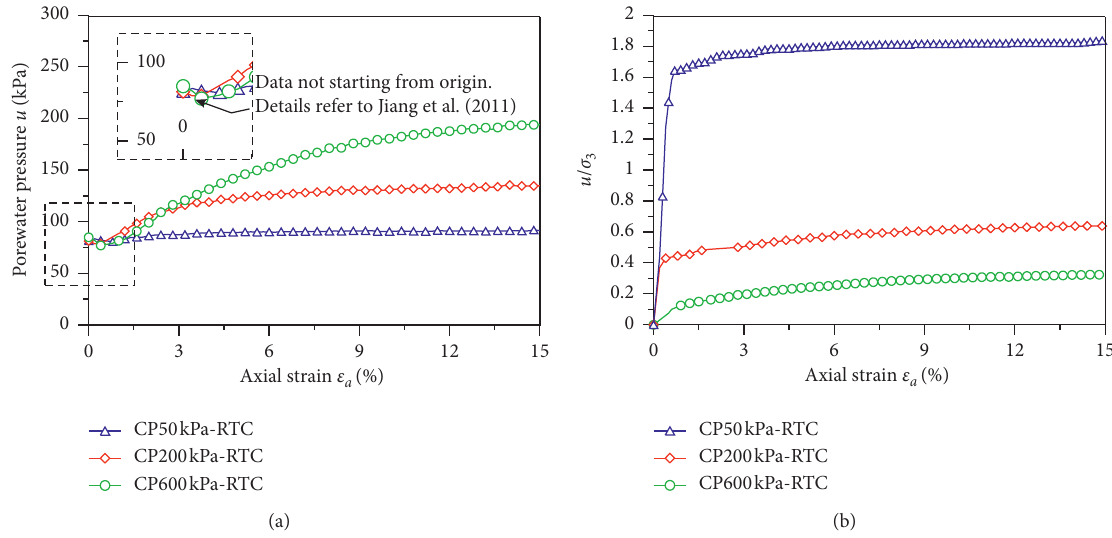
Figure 6: Pore pressure response of Jingyang loess under the RTC stress path: (a) pore pressure u versus axial strain ε axial strain ε a .